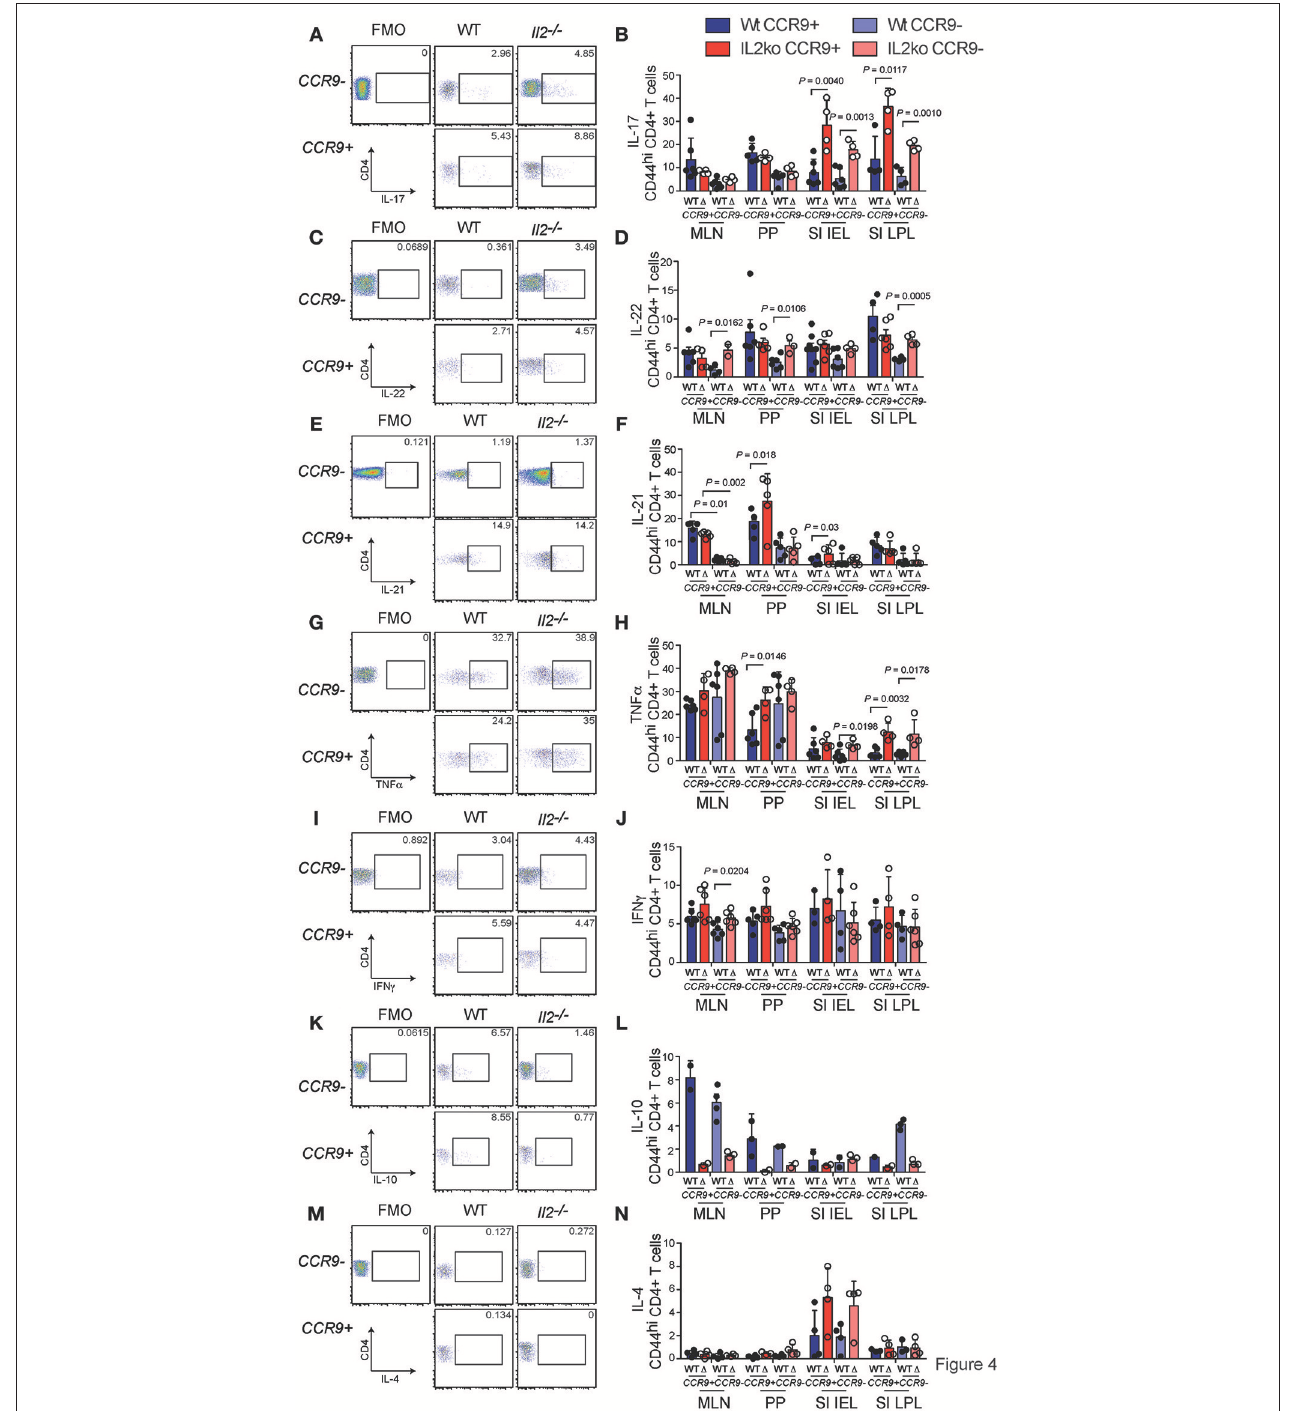
FIGURE 4 | CCR9 + CD4 + Th cells exhibit a distinct cytokine profile in the inflamed GIT. Detection of cytokines in CCR9 + and CCR9 − Th cells from GIT associated lymphoid tissues of Il2 − / − and WT mice by intracellular immunostaining and FACS analyses. (A) Representative FACS dot plot and (B) quantitation of IL-17. (C) Representative FACS dot plot and (D) quantitation of IL-22. (E) Representative FACS dot plot and (F) quantitation of IL-21. (G) Representative FACS dot plot and (H) quantitation of TNF α . (I) Representative FACS dot plot and (J) quantitation of IFN γ . (K) Representative FACS dot plot and quantitation (L) of IL-10. (M) Representative FACS dot plot and (N) quantitation of IL-4. MLN, mesenteric lymph nodes; PP, Peyer’s Patches; SI IEL, intraepithelial lymphocytes of the small intestine; SI LPL, lamina propria lymphocytes of the small intestine; LI IEL, intraepithelial lymphocytes of the large intestine; LI LPL, lamina propria lymphocytes of the large intestine. Data are shown as mean ± SD, where n = 3–6 female mice of 7–9 weeks of age. Statistical significance was analyzed by students T -test.